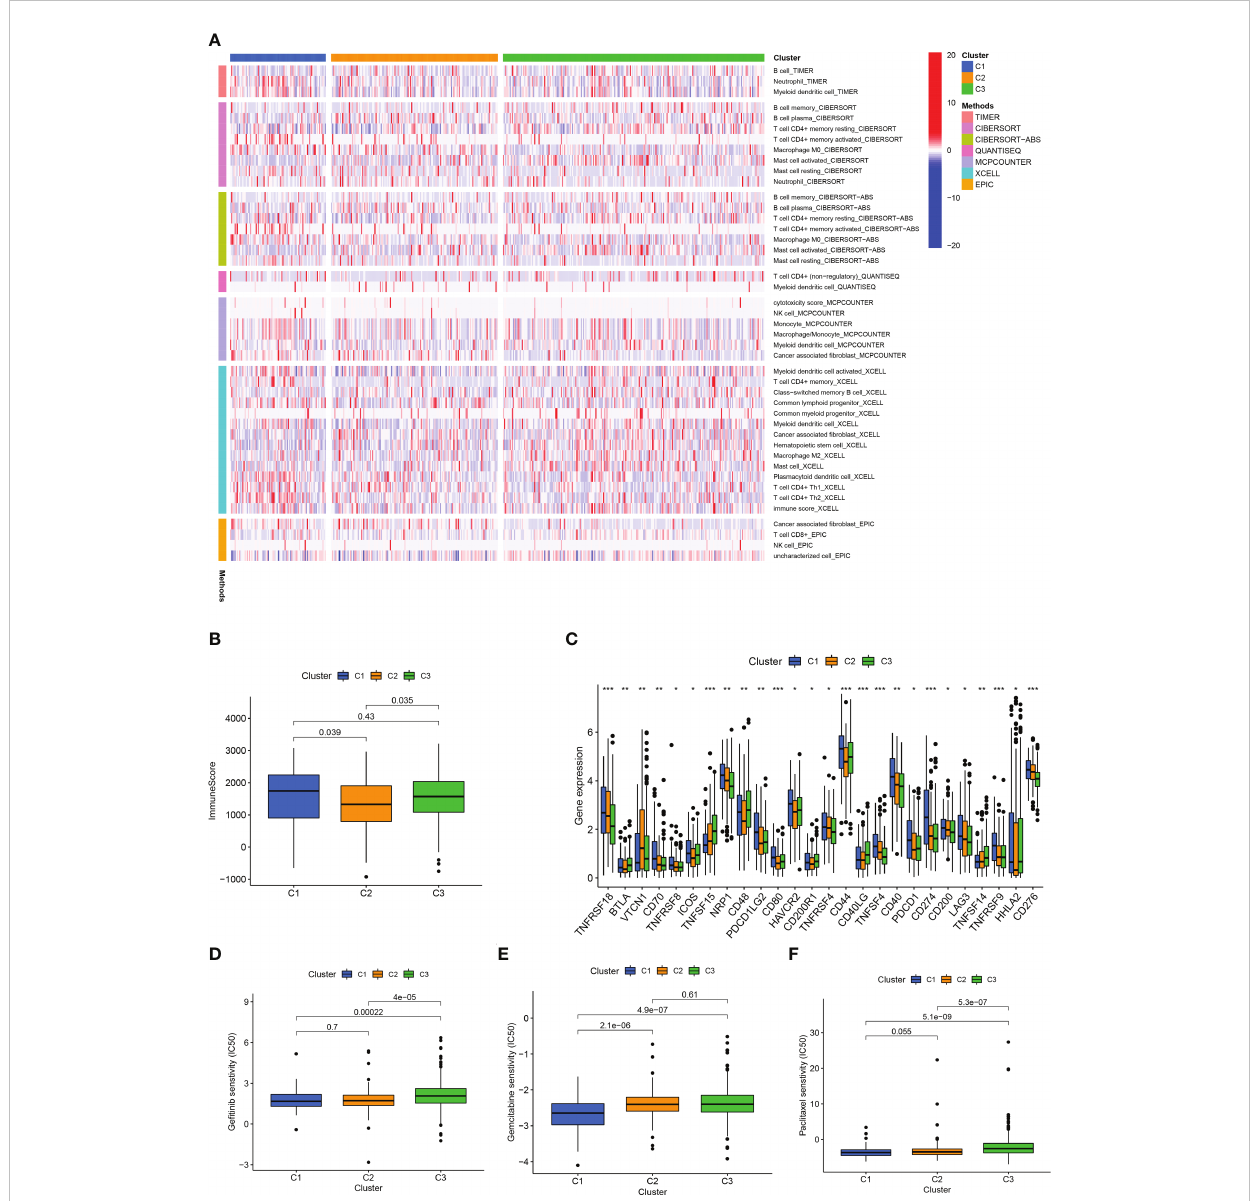
FIGURE 11 Different cluster immunity and drug sensitivity. (A) Heat maps of immune cells in different clusters. (B) Immune scores of different clusters. (C) Differential expression of immune checkpoint genes in different clusters. (D – F) IC50 of different clusters in ge fi tinib, gemcitabine, paclitaxel. *p < 0.05; **p < 0.01; ***p <